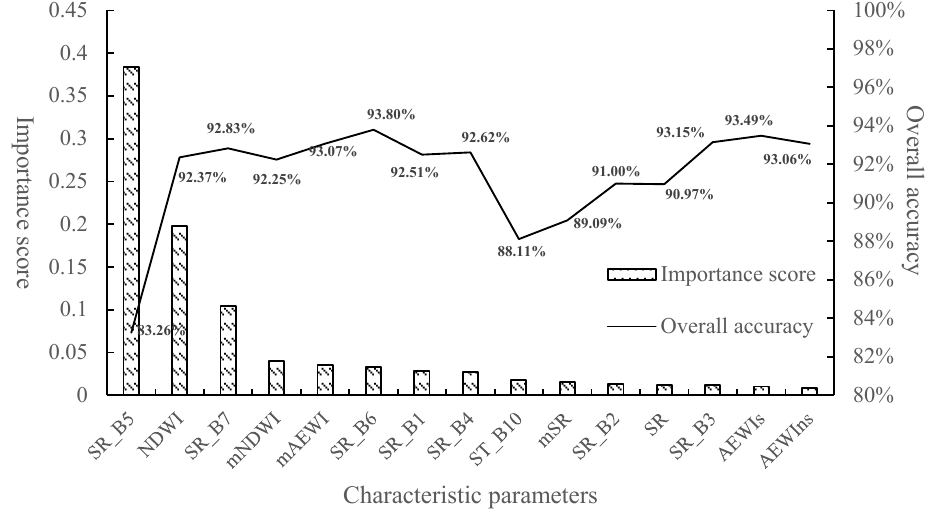
Figure 4. Evaluation and selection results of characteristic parameters.